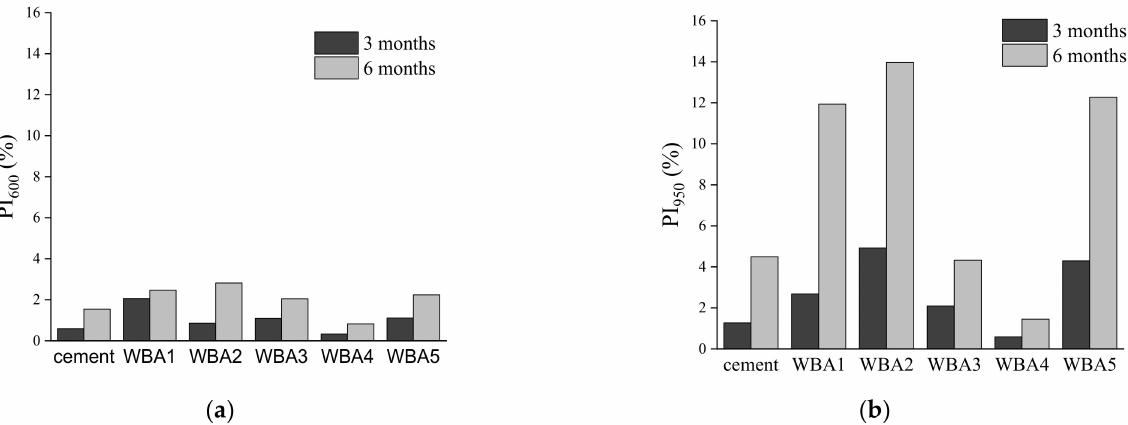
Figure 11. ( a ) PI 600 value for WBA samples (aged for 3 and 6 months) for the temperature range between 35 and 600 ◦ C; ( b ) PI 950 value for WBA samples (aged for 3 and 6 months) for the temperature range between 35 and 950 ◦ C.